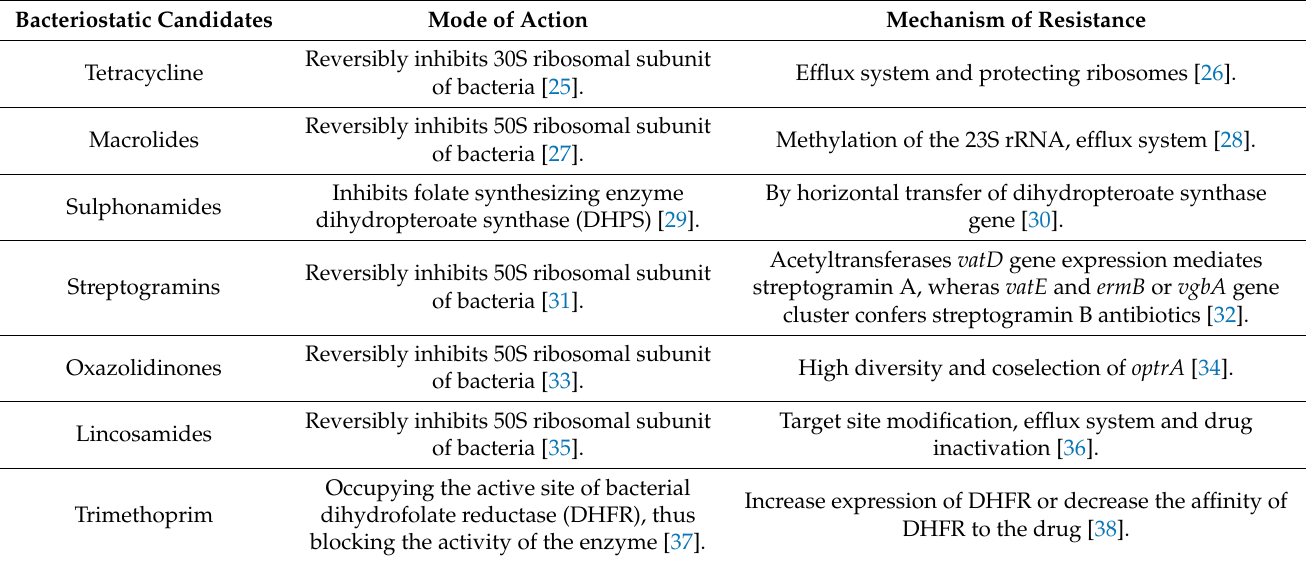
Table 1. Action and common resistance mechanisms of major bacteriostatic